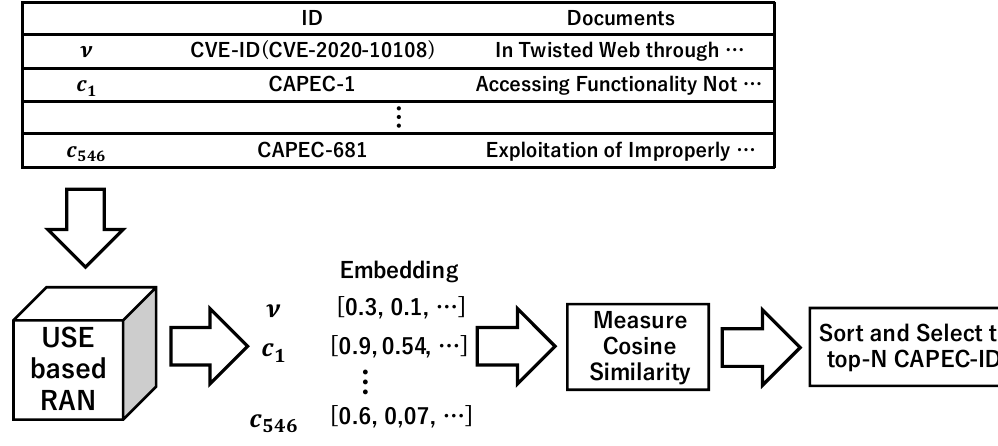
Figure 5. Overview of the tracing based on the Universal Sentence Encoder (USE) algorithm.